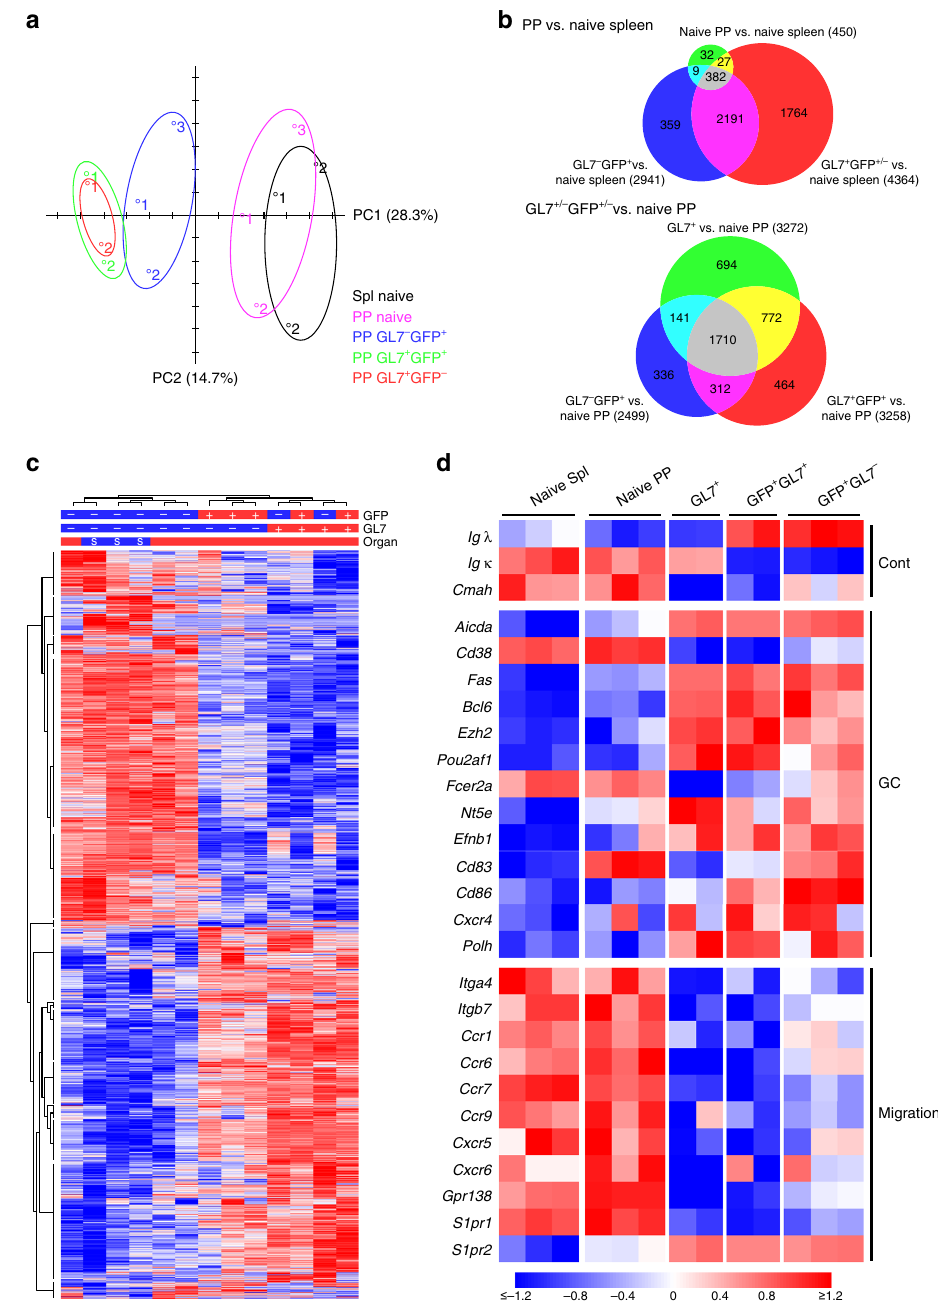
Fig. 3 RNASeq analysis of GL7 + and GL7 − antigen-speci fi c Peyer ’ s patch (PP) B cells. a GFP + antigen-speci fi c B cells were sorted into GL7 + or GL7 − populations on day ten following an oral immunization with NP-CT and their gene expression pro fi les were analyzed using RNAseq. Concomitantly GL7 − (naïve) and GL7 + B cells from PP and GL7 − B cells from the spleen of unimmunized control mice were sorted for a comparative analysis of gene expression pro fi les. A principle component analysis of RNAseq data demonstrated global gene expression similarities between GL7 + and GL7 − GFP + B cells that were distinctly different from GFP − naïve splenic or PP B cells, but similar to endogenous activated GFP − GL7 + GC B cells. b Venn diagrams comparing gene expression changes between groups. In the upper panel, naïve GL7 − ( n = 3 samples), activated PP GFP + GL7 − ( n = 3) and activated GFP + / − GL7 + PP ( n = 4) PP B cells were compared to GL7 − naïve splenic B cells ( n = 3), and in the lower panel activated PP GFP + GL7 − ( n = 3), GFP + GL7 + PP ( n = 2) and GFP − GL7 + PP ( n = 2) were compared to naïve GL7 − PP B cells ( n = 3). Genes with a fold change > 1.5 and FDR adjusted p -value < 0.05 were counted, and the fi gures in each Venn fi eld indicate the number of shared genes between groups. c Heat map of global gene expression in the PP B cell subpopulations compared to that of sorted naïve splenic B cells. d Heat map depicting the mRNA expression of selected genes in different B cell subpopulations, demonstrating differences between GL7 + and GL7 − NP-speci fi c GFP + B cells with regard to gene expression signatures associated with migratory cues but similarities in expression of GC genes. Differences in gene expression are indicated the same in c and d with the scale at the bottom being applicable to